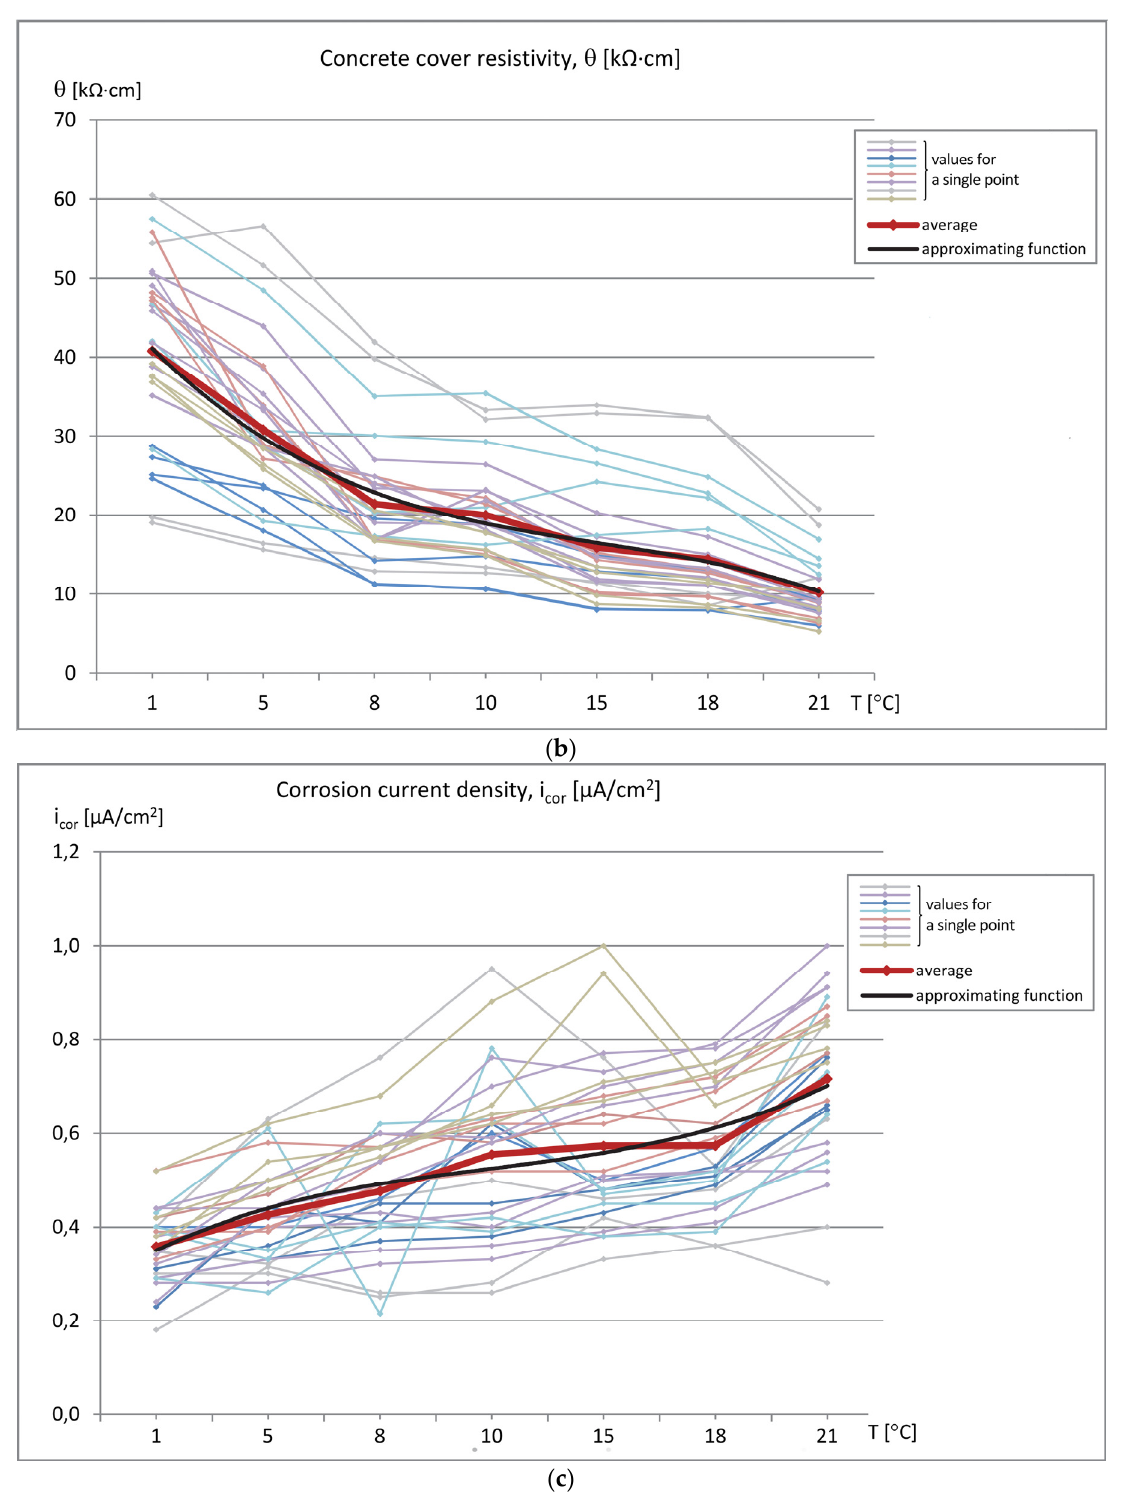
Figure 6. Parameter values measured on specimens at various temperatures; ( a ) reinforcement stationary potential, ( b ) concrete cover resistivity, ( c ) corrosion current density